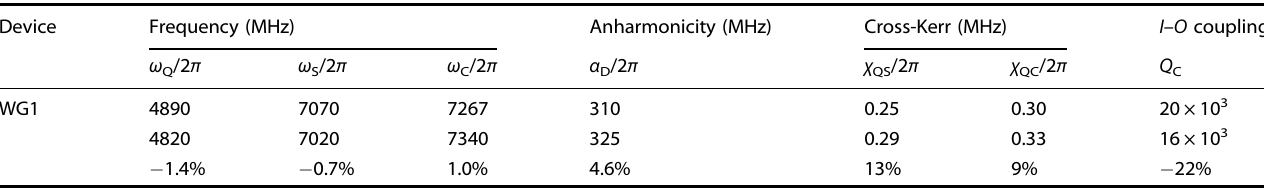
Table 2. Flip-chip (2.5D), one-qubit, one-storage-cavity, one-readout-cavity devices. Device